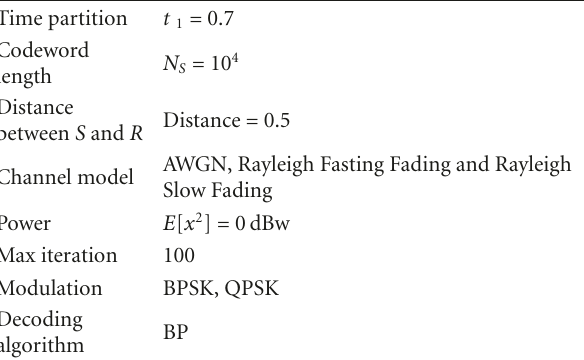
= R t 1 = 0 . 5. S 1 R S 2 R